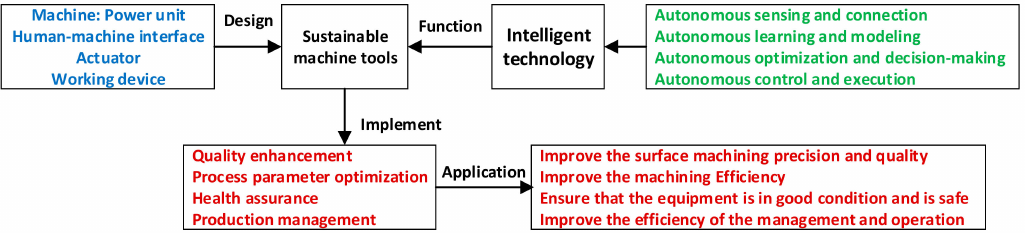
Figure 9. The integration of intelligent technology and machine